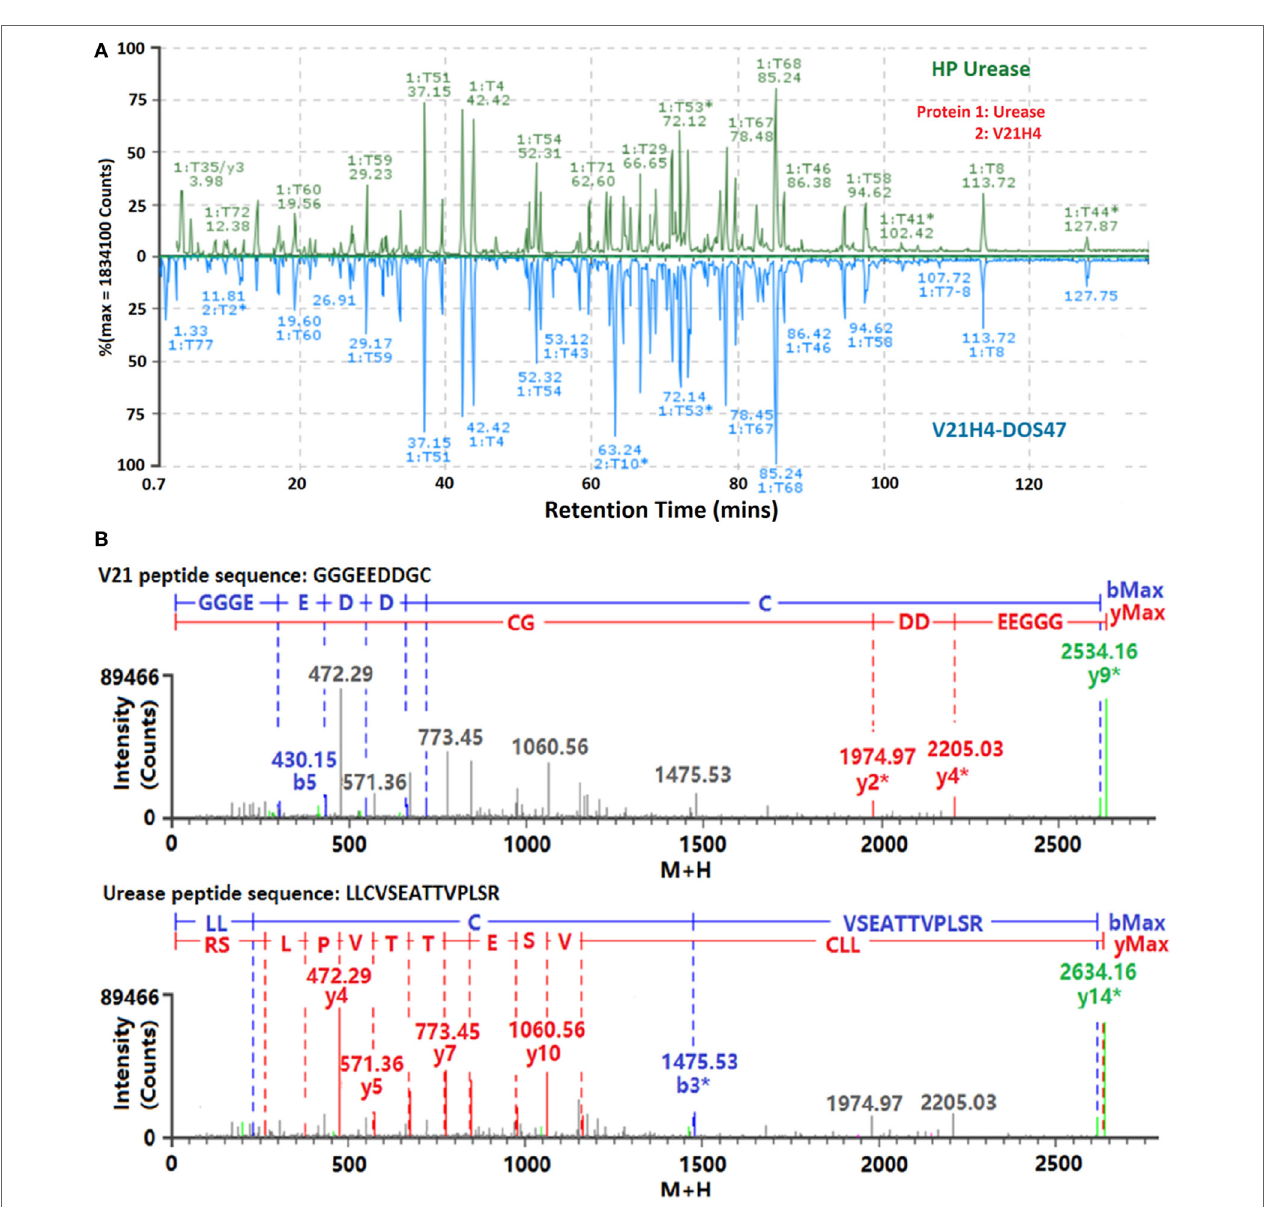
FigUre 8 | (a) Screen snapshots of raw LC-MS (TIC) chromatograms of tryptic digests of HP urease (top) and V21H4-DOS47 (bottom) samples processed by BiopharmaLynx software. (B) Screen snapshots of b / y fragment profiles of conjugation site UC 824 –VC 136 mapped as the V21H4 peptide GGGEEDDGC (top) modified by UC 824 -BM(PEG) 2 and as the urease peptide LLCVSEATTVPLS (bottom) modified by VC 136 -BM(PEG) 2